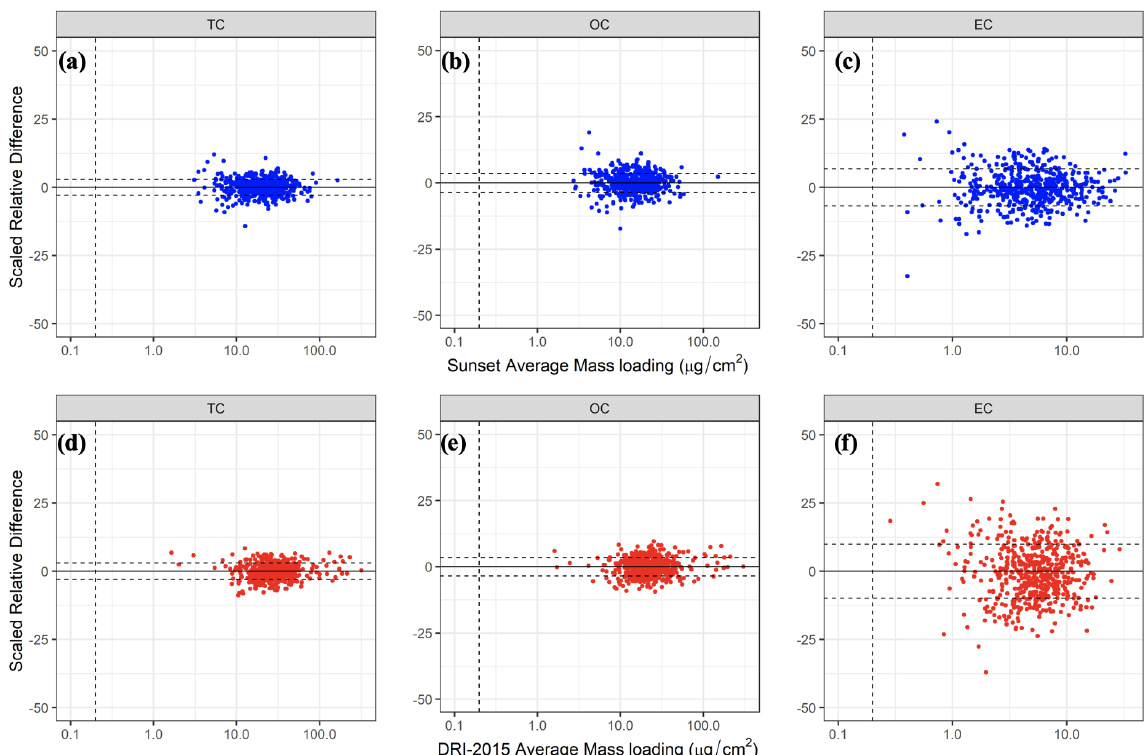
Figure 2. Scaled relative difference (Eq. 5, %) of TC, OC, and EC calculated from the original and replicate paired analyses performed on 2017 CSN samples by the Sunset analyzers ( a–c , n = 519) and the DRI model 2015 analyzers ( d–f , n = 518) as a function of the average mass loading of the paired analyses. The horizontal dashed lines in each plot represent ± 1 σ of the SRD determined for each carbon component. The vertical dashed line intercepted at mass loading of 0.2µgcm − 2 indicates the method detection limit (MDL).